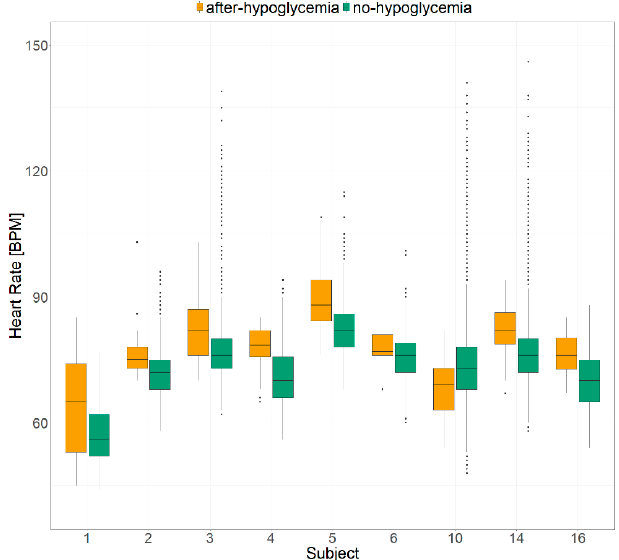
Figure 2. Comparison between the heart rate values collected in the hour after a hypoglycemic episode (in orange) and in sleep intervals without hypoglycemic episode (in green).